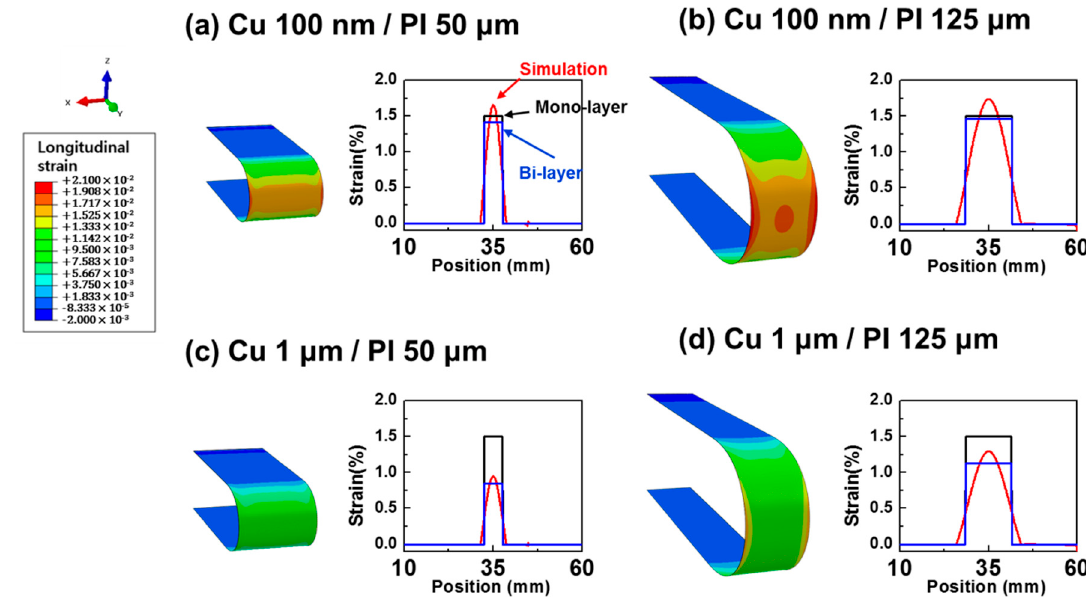
Figure 5. Finite-element method (FEM) modeling and strain distributions: ( a ) 100 nm thick Cu on 50 µm thick PI, ( b ) 100 nm thick Cu on 125 µm, ( c ) 1 µm thick Cu on 50 µm thick PI, and ( d ) 1 µm thick Cu on 125 µm thick PI.